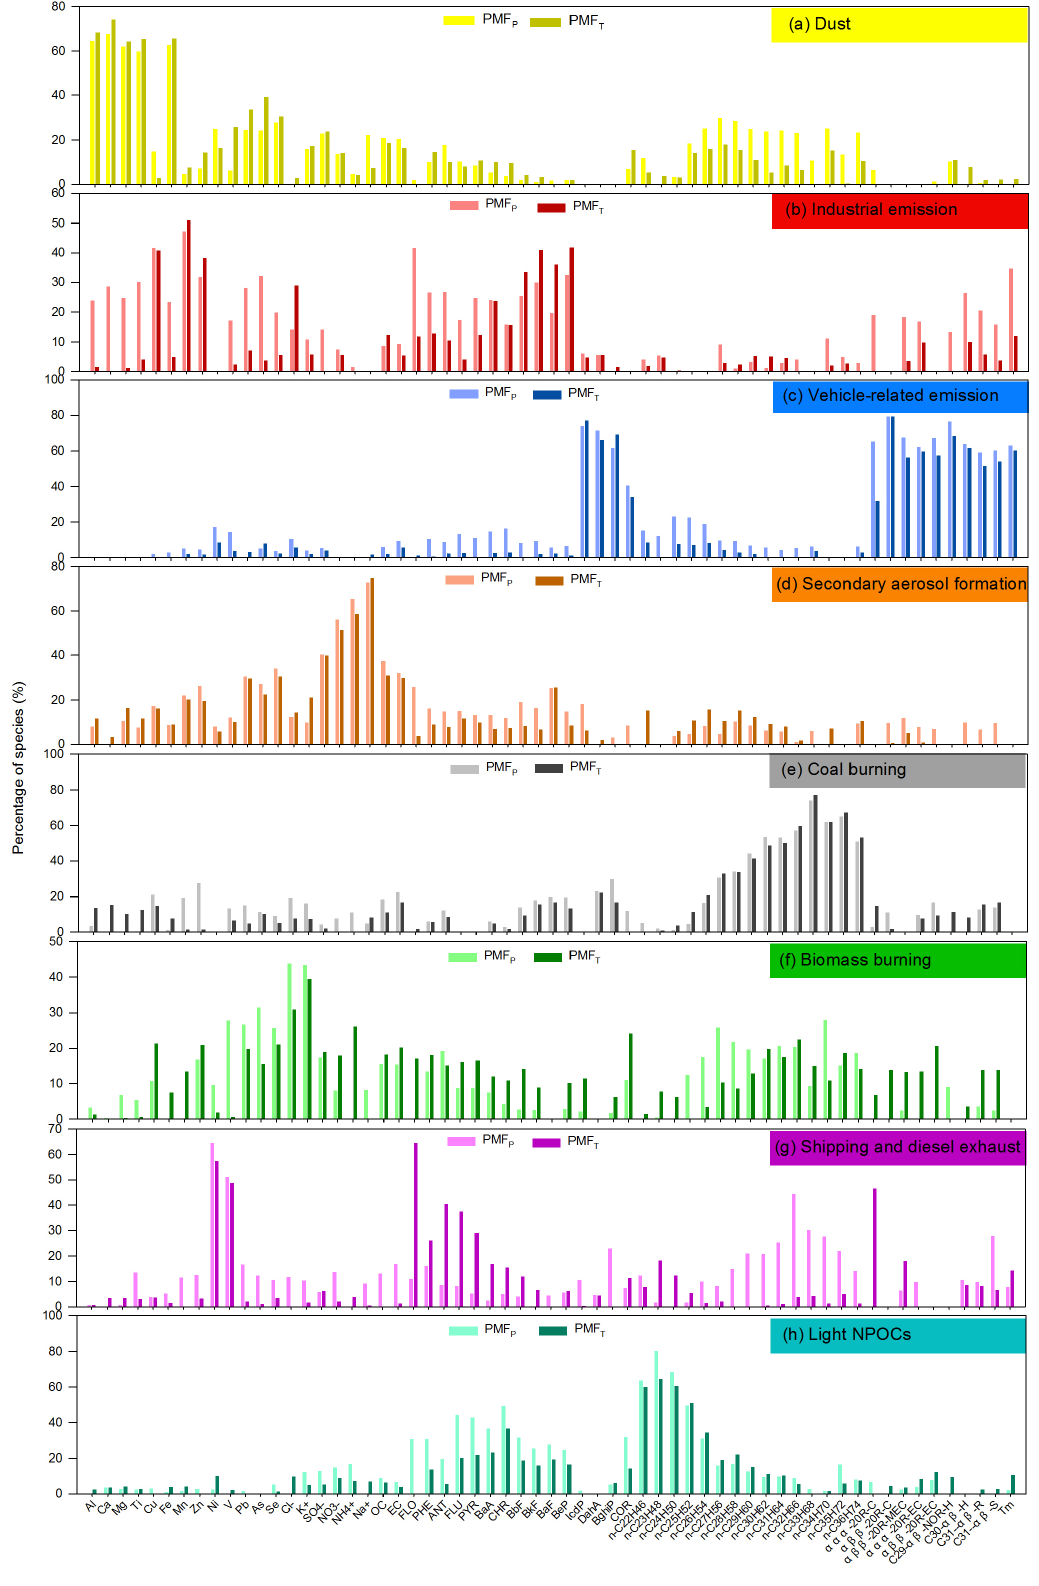
Figure 7. Source profiles of eight sources resolved by